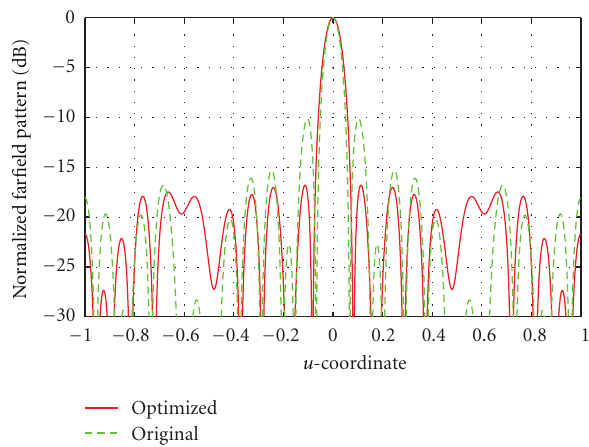
Figure 7: Radiation pattern of the original stage 3 Sierpinski carpet array.